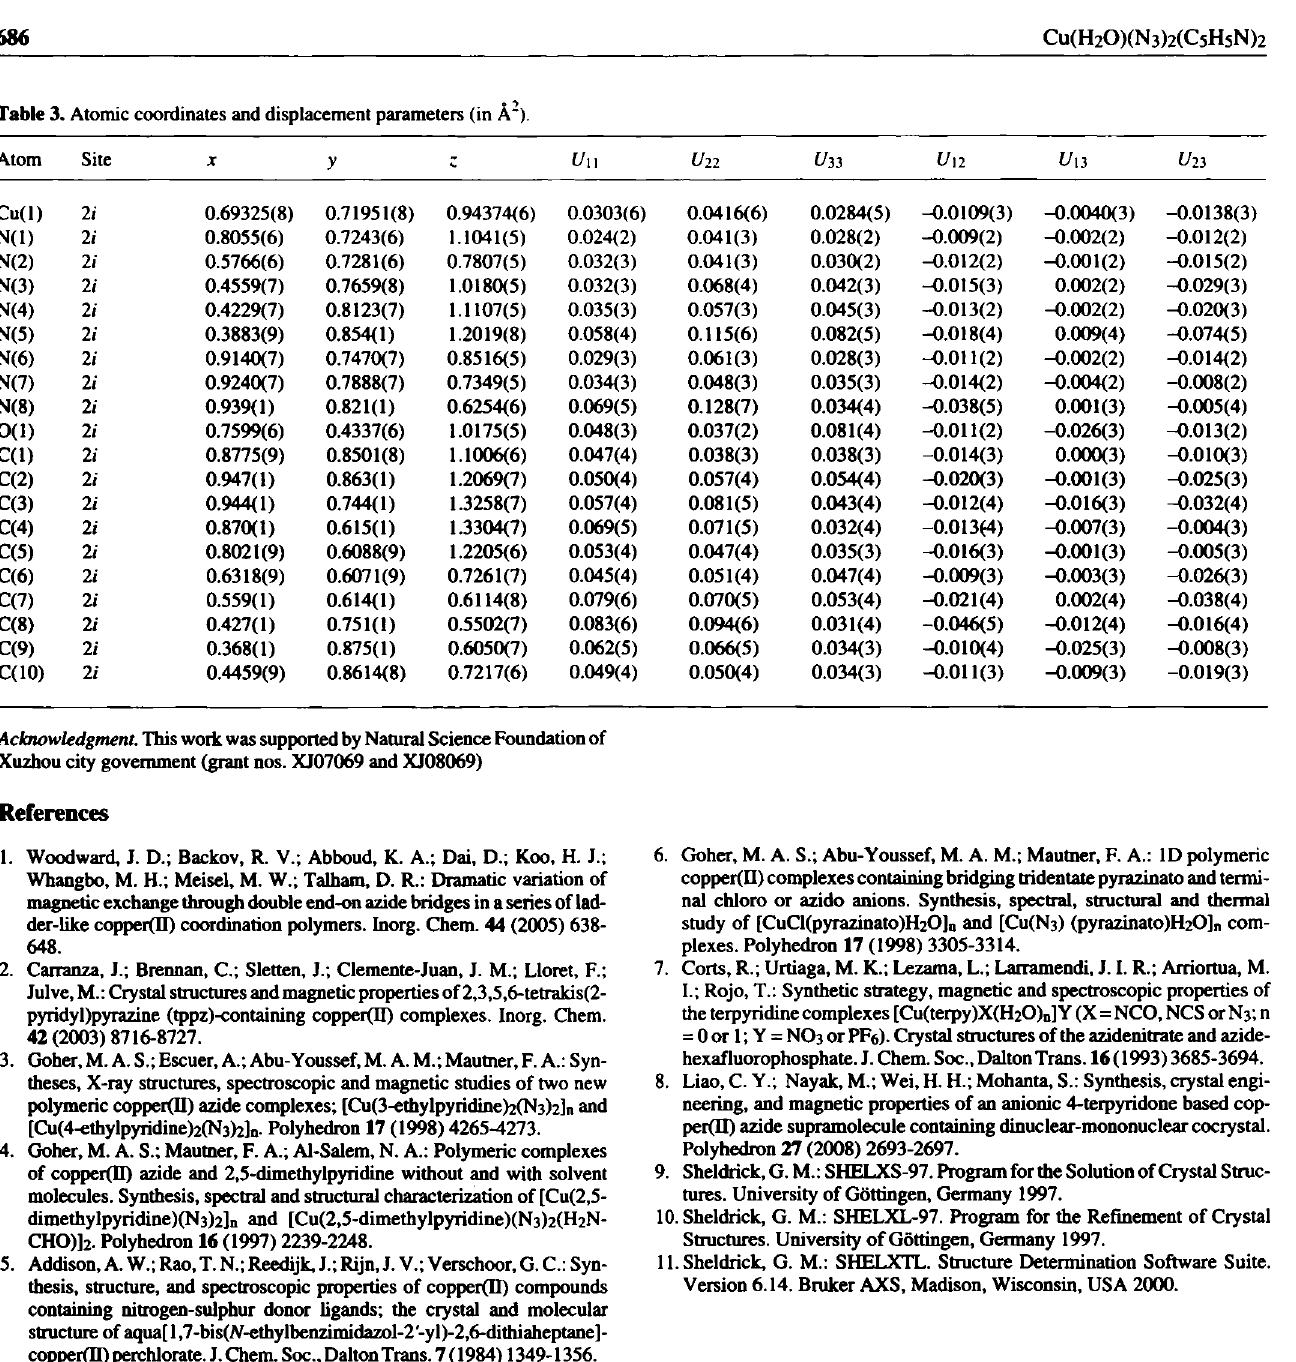
Table 3. Atomic coordinates and displacement parameters (in